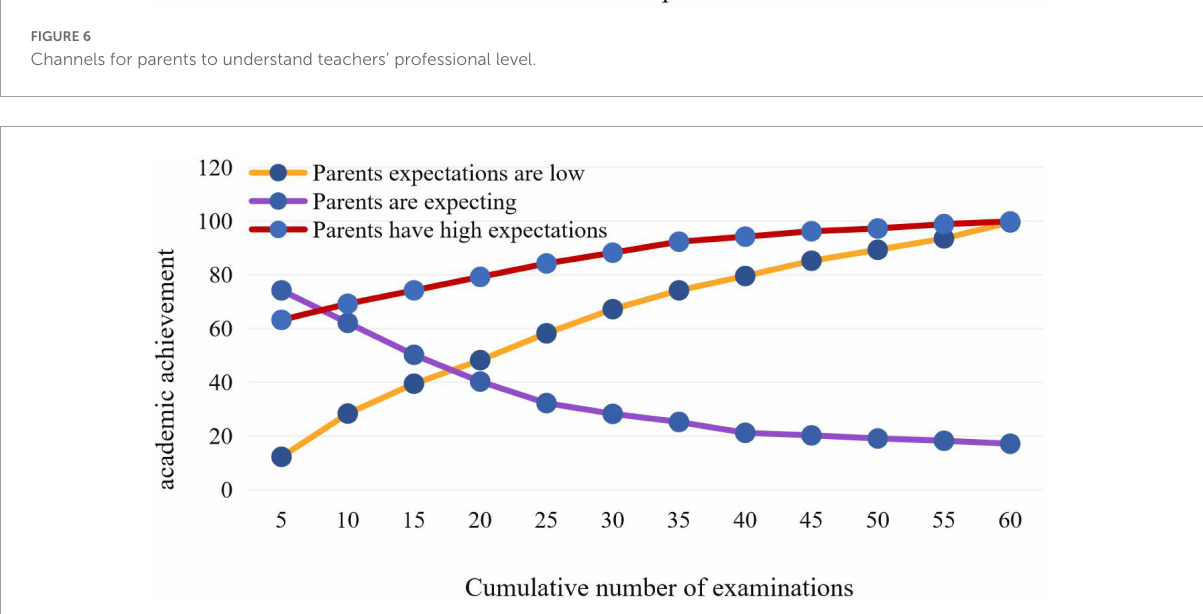
FIGURE7 Trend chart of parents’